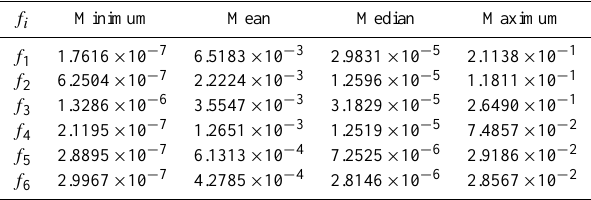
Table 1. The minimum, mean, median and maximum of H ( 1 , 2 ) mm ob- tained in the ensemble of 100 experiments for each f i .